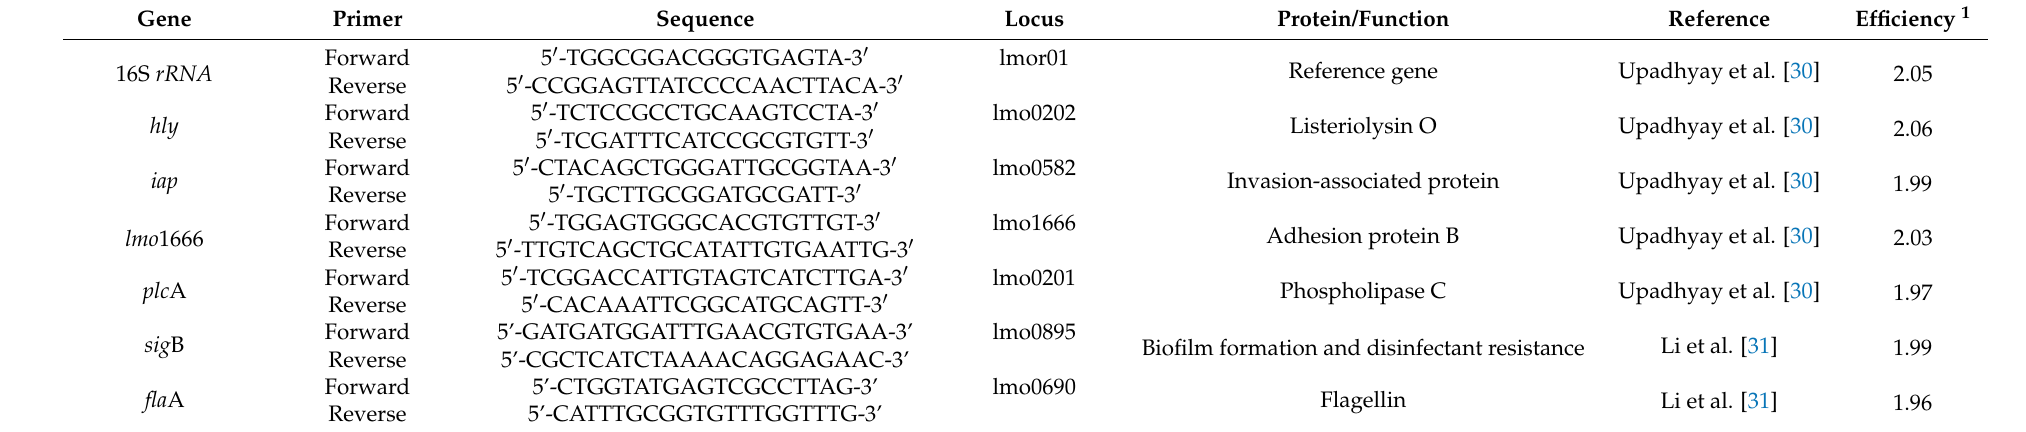
Table 1. Information about the primers used in Quantitative